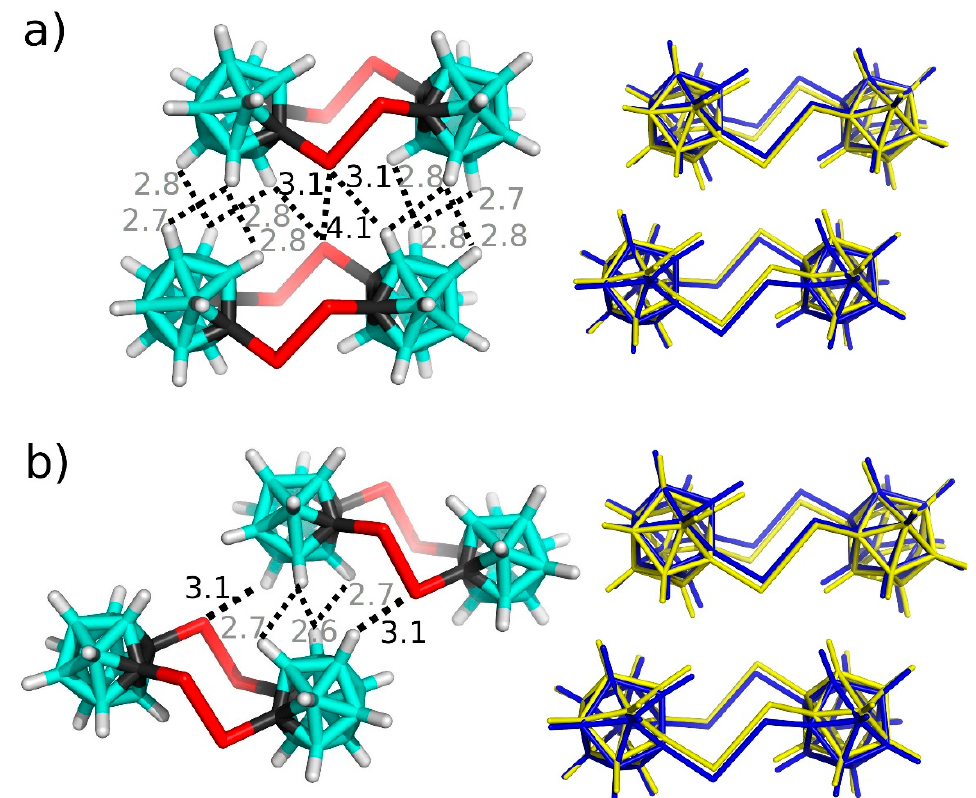
Figure 5. Two most stable binding motifs of the single crystal of Te 4 C 4 ( a ) and ( b ). The left column: X-ray geometries (only the positions of H atoms optimized) and distances in Å. Distances larger than Σ r vdW are in gray. The rigth column: Comparison of X-ray geometries (blue) with fully optimized structures in the gas phase (yellow). Distances are in Å. The positions of H atoms were optimized at the DFT-D3/BLYP/DZVP level.